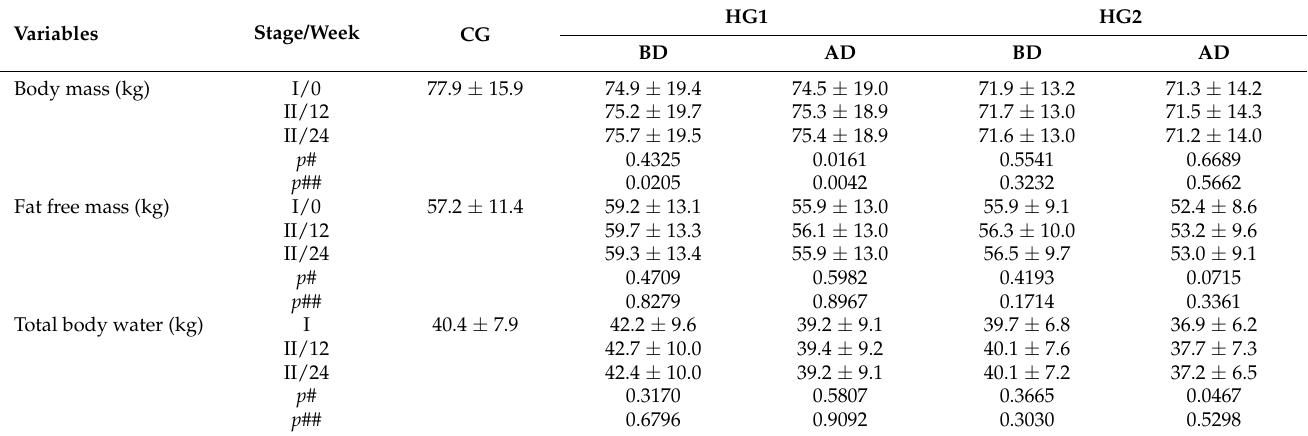
Table 2. Body mass and body composition of the study participants (means ±